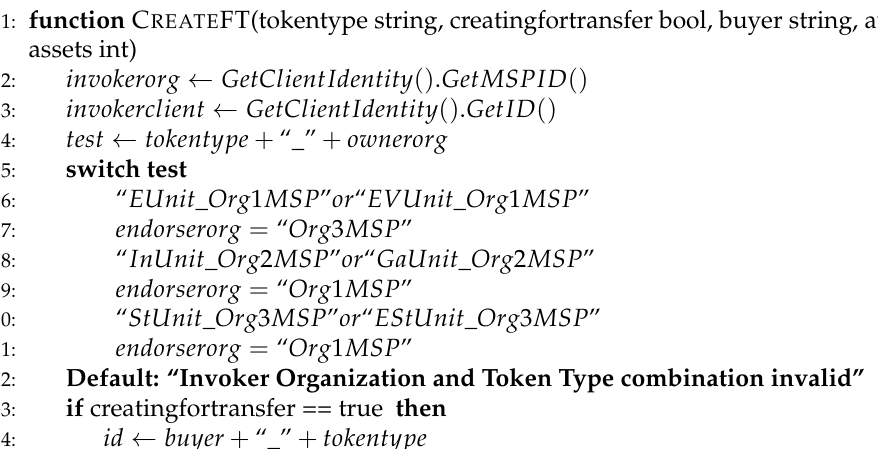
Algorithm 8 Create a